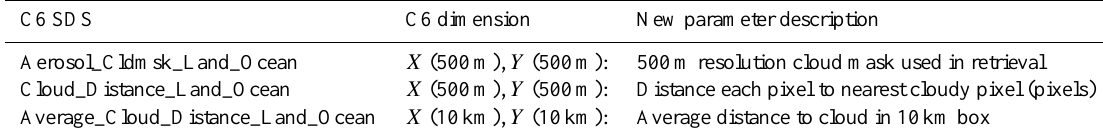
Table 6. C6 New “aerosol” cloud products. C6